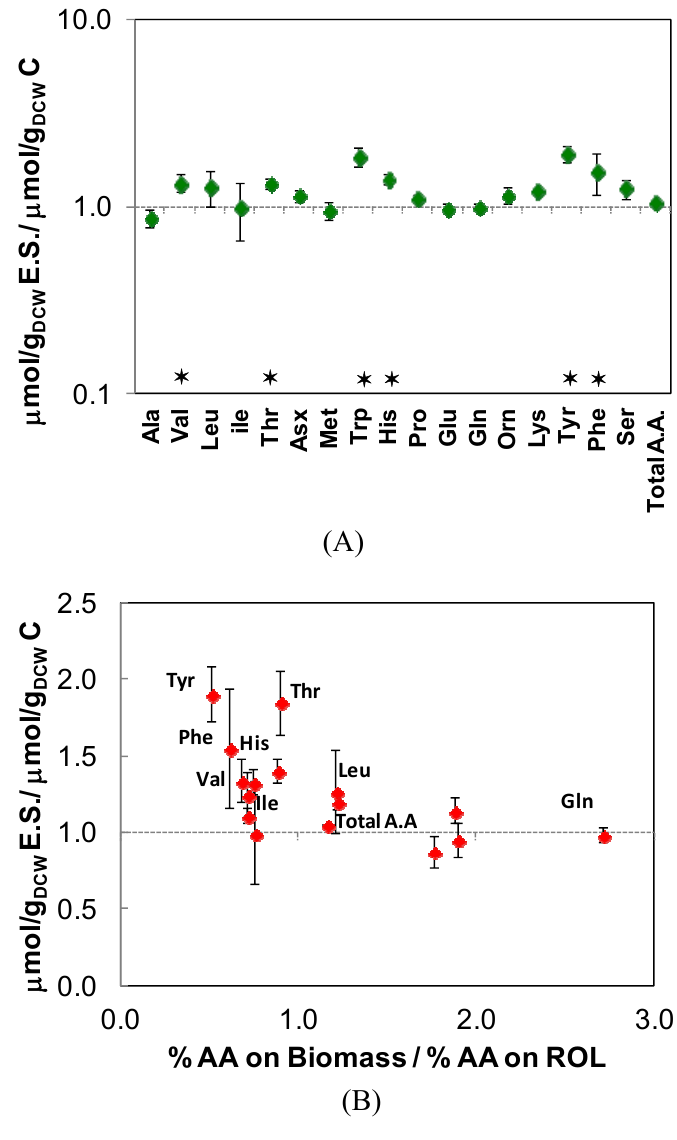
Figure 1. Comparative analysis of amino acid pools. ( A ) Ratio of amino acid pools of the P. pastoris Rol-expressing strain (E.S.) and the control strain (C). The error bars are calculated from error propagation. Two-tailed T-test statistical analyses allowed to identify those metabolite ratios that were significantly higher or lower than 1 (marked by a star). ( B ) Intracellular amino acid ratio over the ratio of protein composition